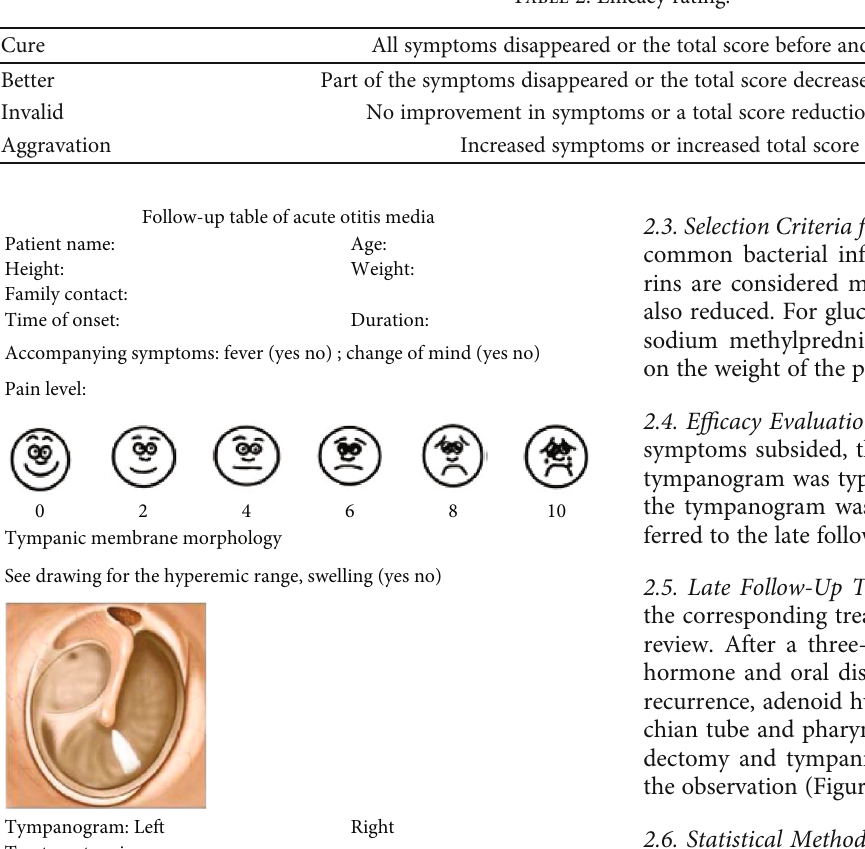
Figure 1: Grading criteria: severity grading of acute nonsuppurative otitis media: (a) normal, (b) grade I, (c) grade II, and (d) – (h) grade III. Table 2: E ffi cacy rating.